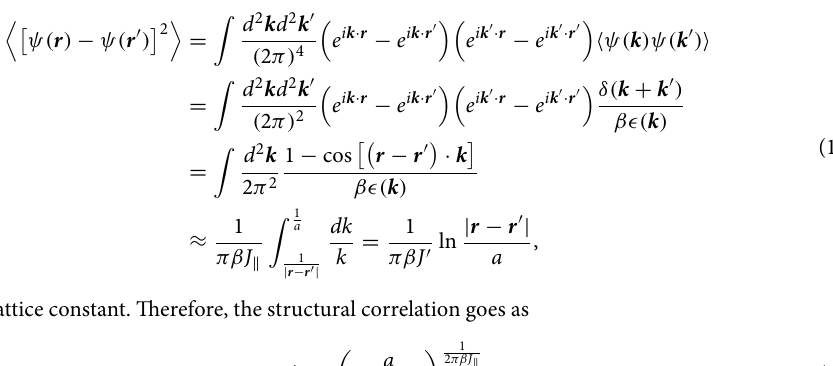
Figure 4. Molar fraction of layers of type A in a mixed-layer clay predicted as functions of parameters J which control the manner of stacking and mean composition,